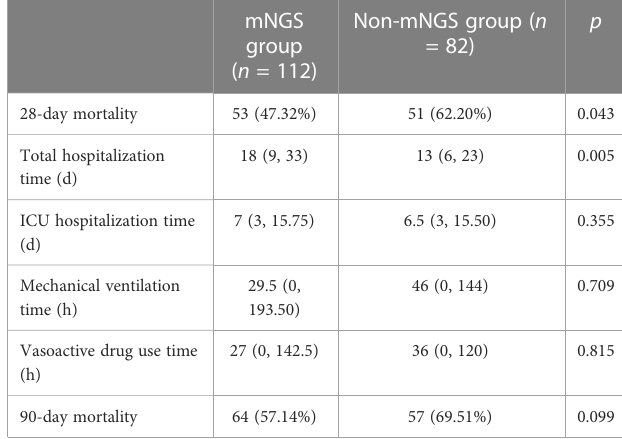
TABLE 1 Comparison of primary and secondary outcomes between mNGS group and non-mNGS